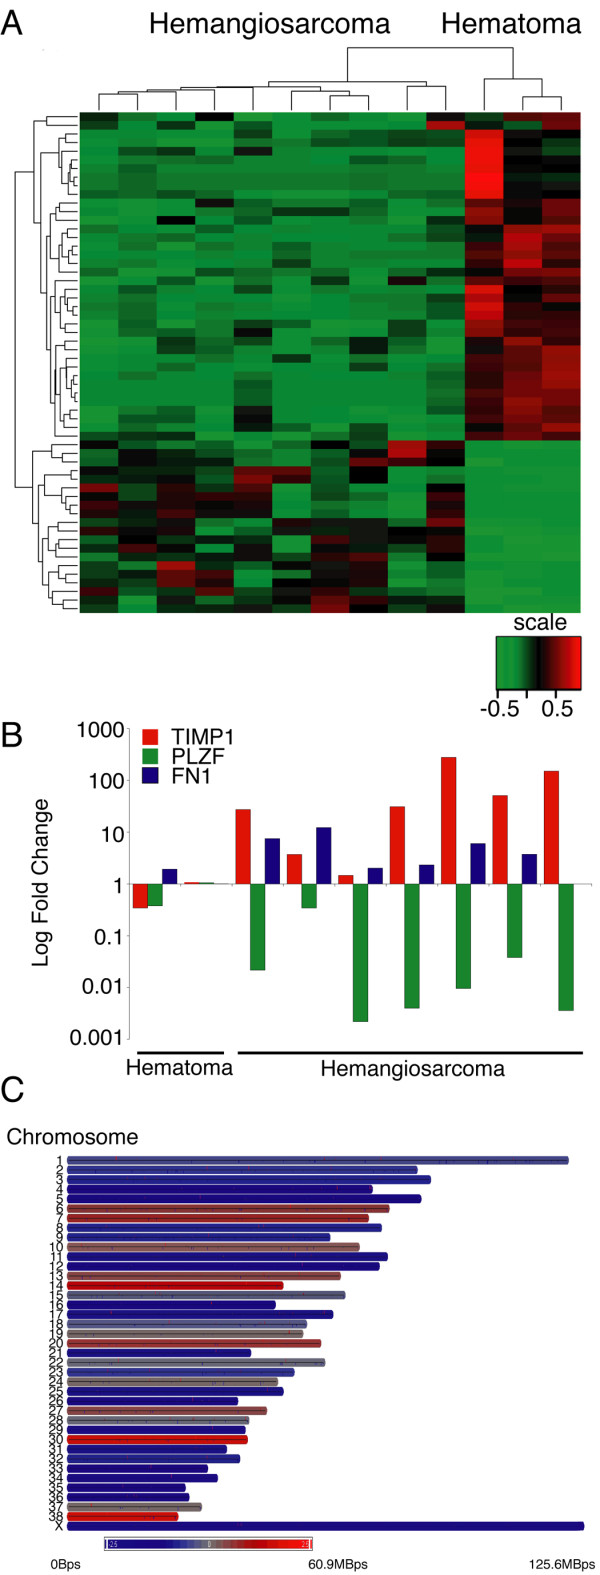
Canine hemangiosarcoma cells segregate from non-malignant splenic hematoma cells via their gene expression profile. (A) Hierarchical clustering and heat map of differentially expressed genes in 10 hemangiosarcoma samples versus three splenic hematoma samples. Increasing red intensity indicates increased gene expression and increasing green intensity indicates decreased gene expression as shown in the scale bar. The scale (-1 to +1) reflects variation in intensity from the mean (0) and not fold-change. Fold-change differences are shown in Table S2. (B) Quantitative expression and graphical representation of 2 genes shown in Figure 2A (TIMP-1 and PLZF) and 1 additional gene (FN-1) that were differentially expressed between hemangiosarcoma and splenic hematoma cells. Samples were evaluated for gene expression changes by RT-qPCR, normalized to the endogenous 18 S gene. One sample originating from a dog with splenic hematoma was set to the unitary value (1.0) and used as the calibrator; gene expression is presented as the log fold-change compared to the calibrator. (C) Genes whose expression was significantly different (p <0.05) between hemangiosarcomas and splenic hematomas based on analysis of variance of the complete filtered lists were plotted according to their cytogenetic location on the 38 canine autosomes and the X chromosome. The color intensity for each chromosome (red-over represented to gray to blue-under represented) represents the sum of all changes.